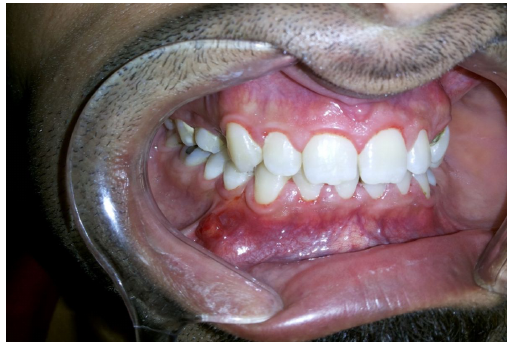
Figure 4: Screw site infection developed sinus tract after its